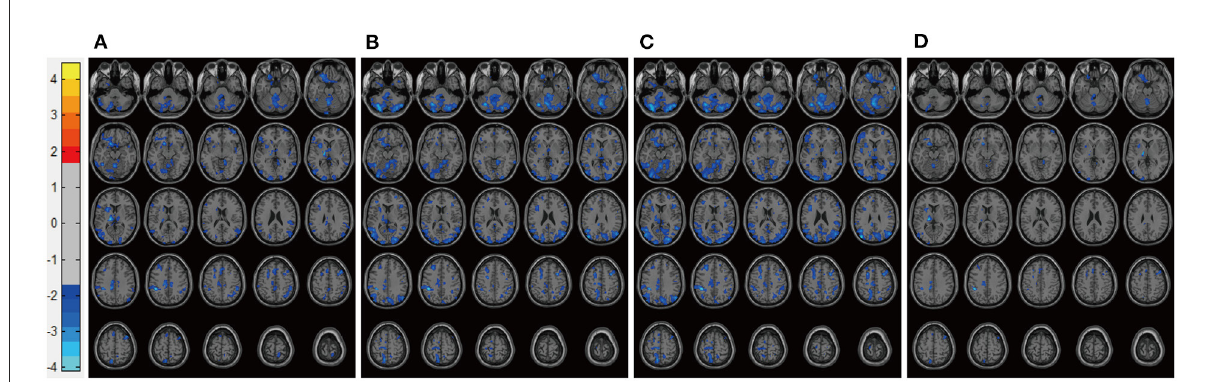
FIGURE1 Representative images of pretreatment rs-CBF in patients with BP experiencing their first depressive episodes compared with the rs-CBF of healthy controls. (A) Before lithium monotherapy, (B) before LTG monotherapy, (C) before treatment with lithium and LTG, (D) before treatment with VPA and LTG. rs-CBF, resting-state cerebral blood flow; BP, bipolar disorder; LTG, lamotrigine; VPA,